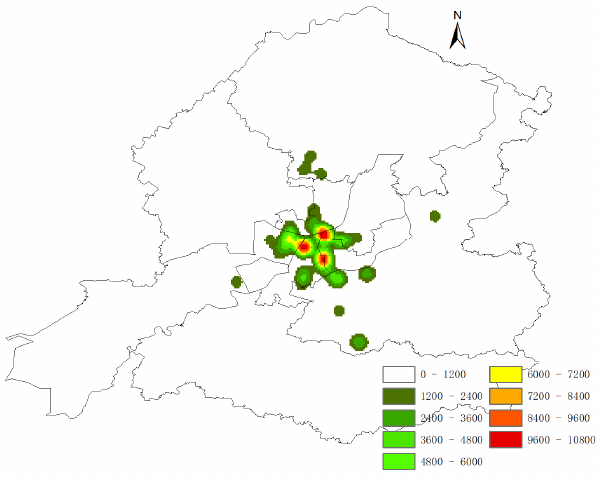
Figure 4. Results of kernel density analysis of